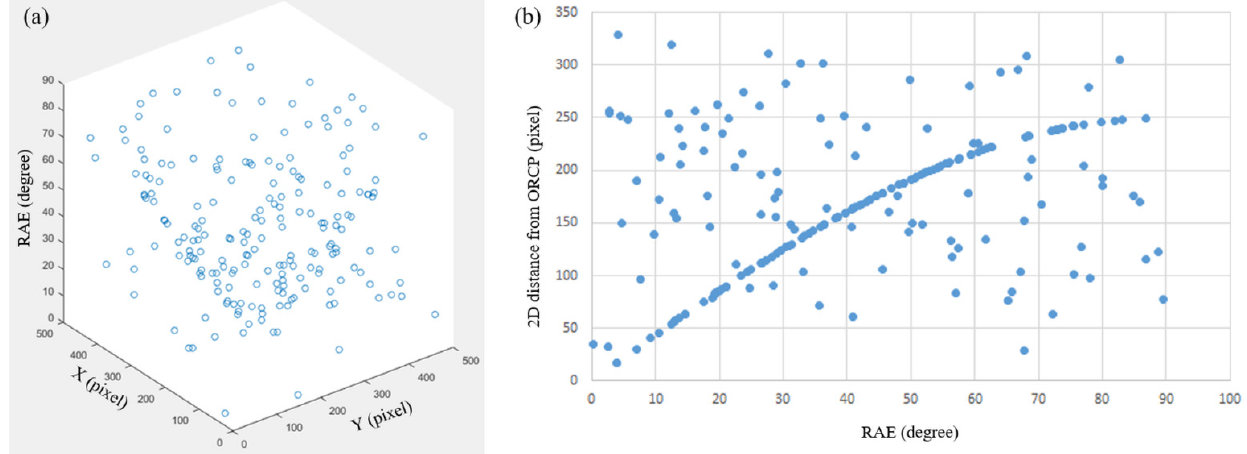
Figure 4. ( a ) Three-dimensional data distribution diagram. ( b ) Data distribution diagram represented by RAE and the distance of the each data point from ORCP on the xy-plane.